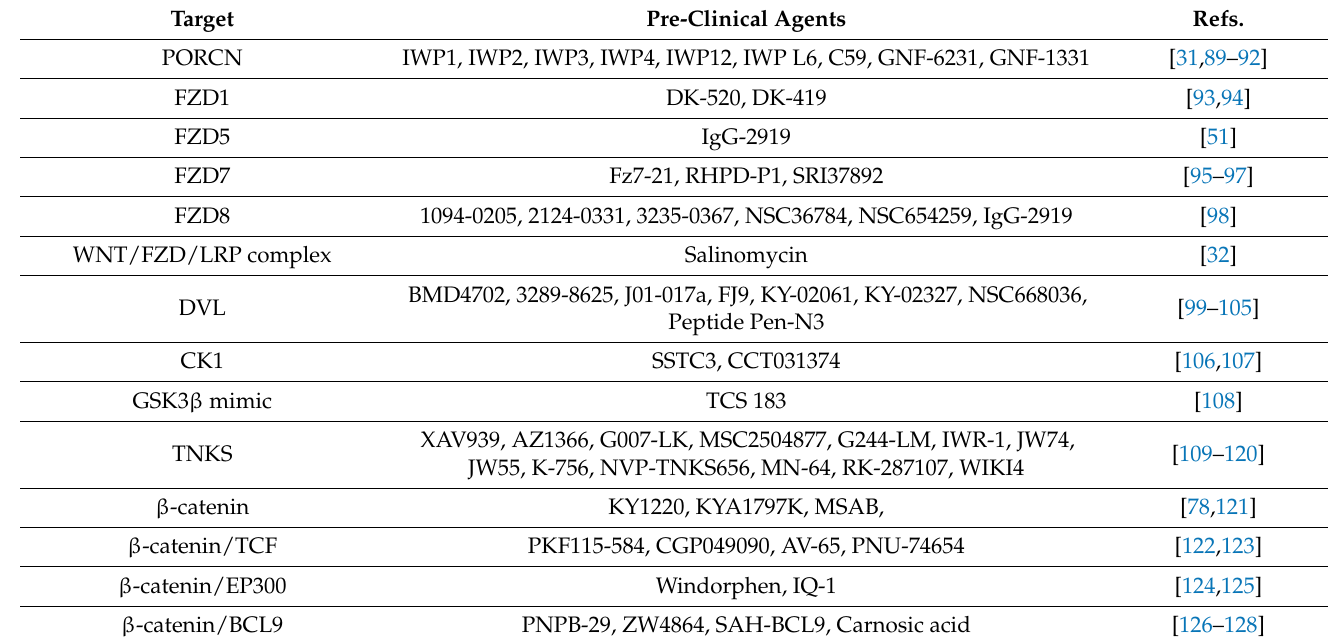
Table 2. Pre-clinical agents targeting Wnt signaling.